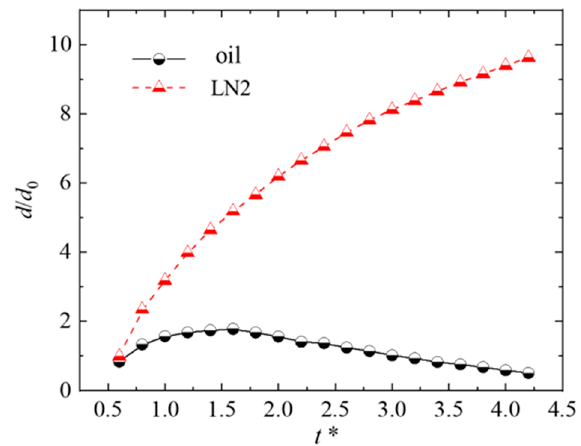
Figure 15. Comparison of spreading coefficient between the oil droplet and the LN2 droplet.